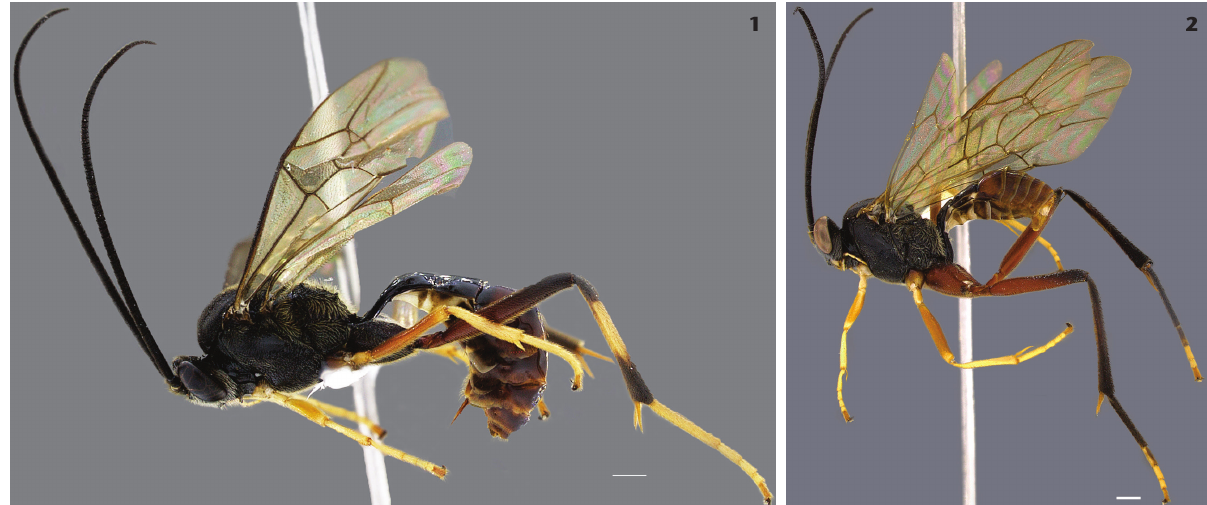
Figures 1-2. Habitus of Cryptophion atlanticus sp. nov. , lateral view: (1) female holotype; (2) male paratype. Scale bar: 0.8